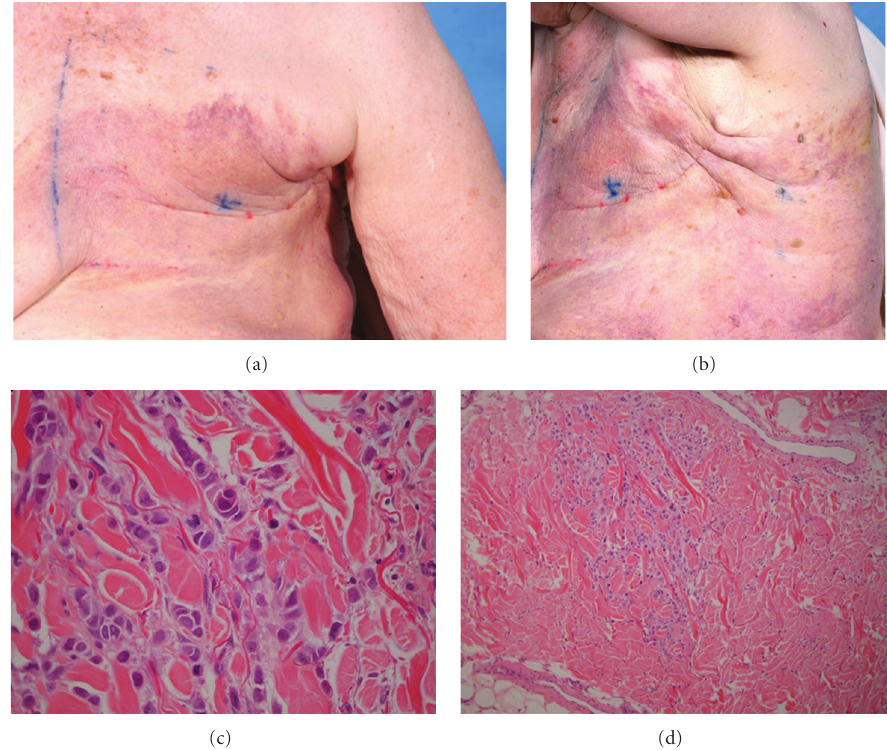
Figure 2: (a) Indurated left mastectomy scar with di ff use erythema and purpura. (b) The skin changes extend into the left axilla and back. (c) Groups of cells with pleomorphic nuclei and pale eosinophilic cytoplasm infiltrating dermal collagen. (d) Dermal infiltration by carcinoma.